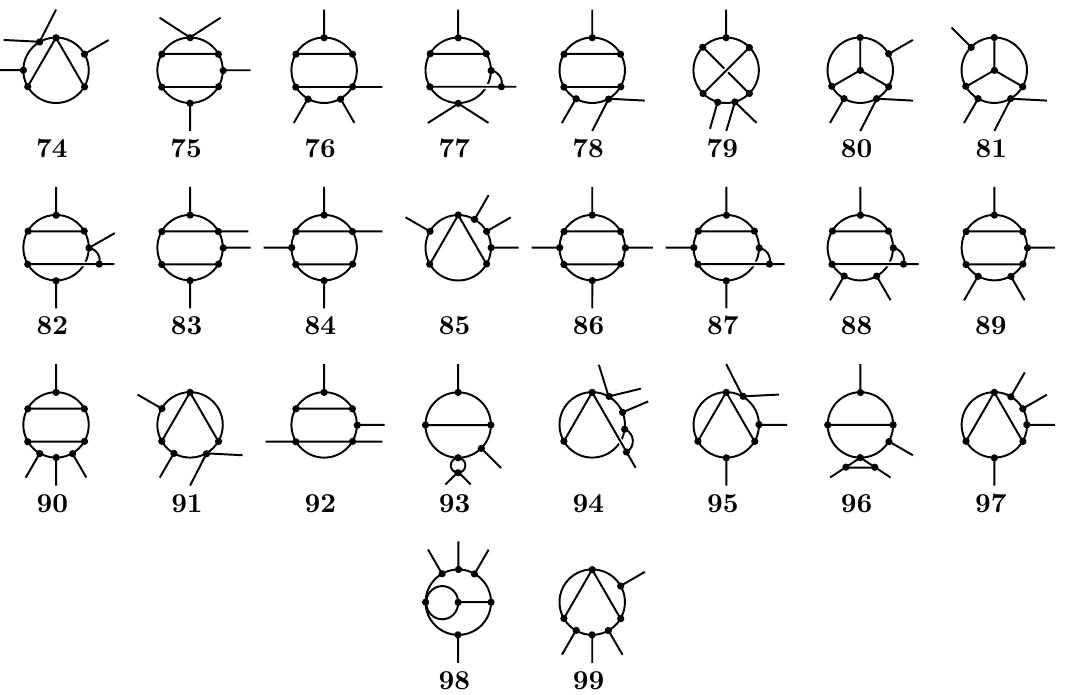
Figure 1 . List of new topologies associated to special genuine diagrams. We follow the numbering of the paper and this list should be understood as a continuation of (cid:12)gure 15 in the appendix A of the paper. See text for details.